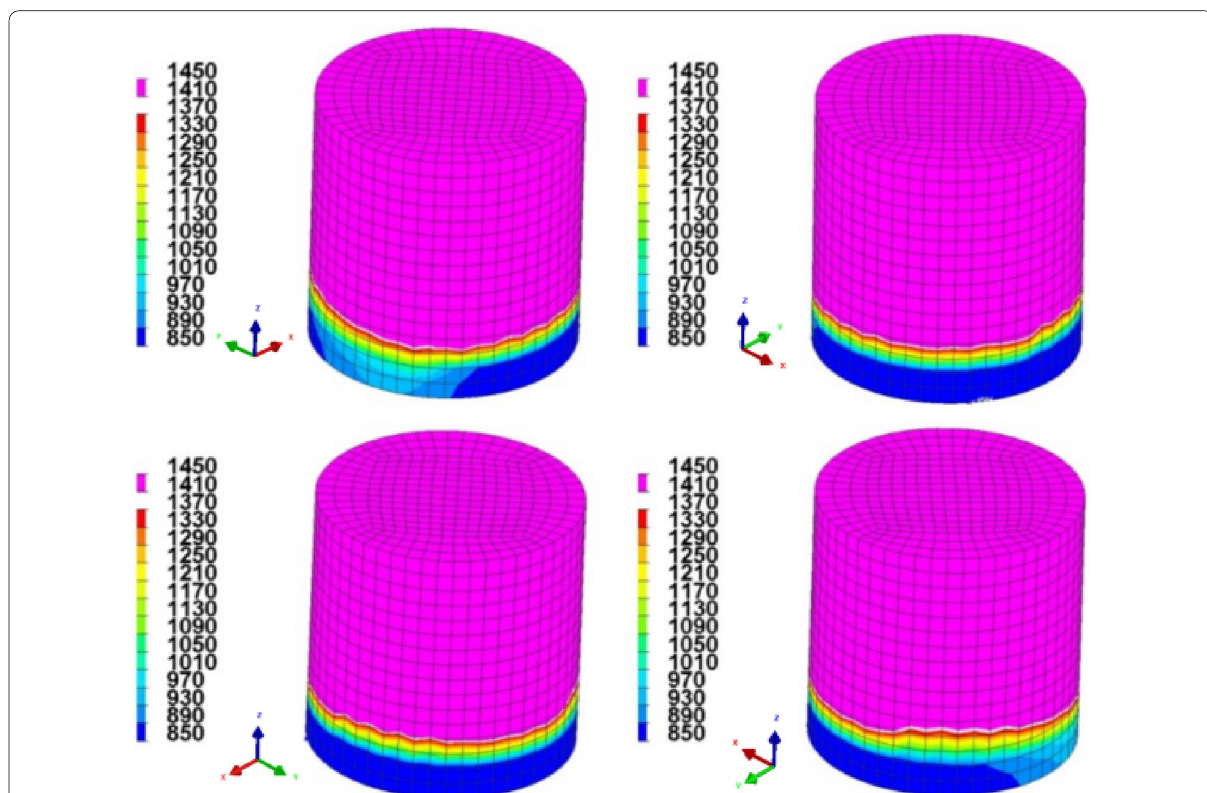
Figure 13 Temperature field distribution cloud map under the welding condition of